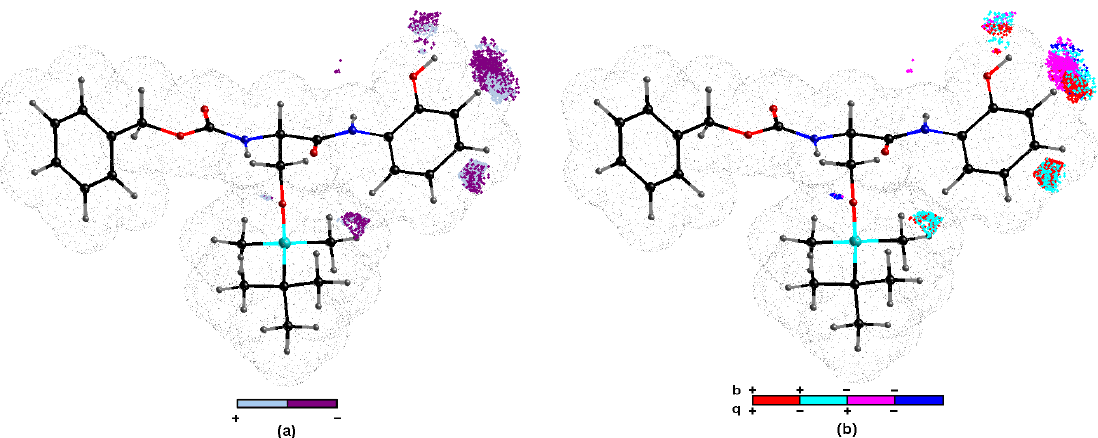
Figure 6. Spatial sectors with the largest contribution into BChE inhibitory potency selected by CoMSA IVE-PLS for 17 / 8 training / test set samplings. Color coded contributions ( a ) and four possible combinations of mean charge q and correlation coe ffi cient b values ( b ) for silicon-based carbamates 1 – 25 . Reference compound 2 is illustrated as the most potent molecule.